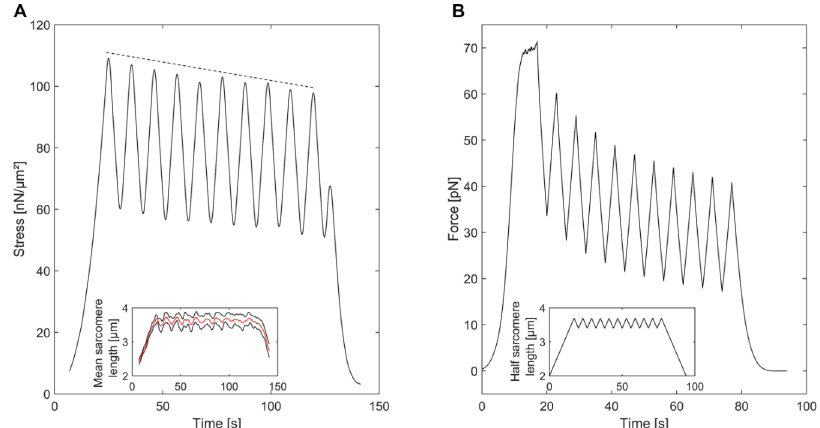
Fig 7. Hysteresis cycles of a single myofibril. A A single myofibril consisting of 7 sarcomeres was stretched to an averaged sarcomere length of 3.7 μ m and subsequently cycled by approximately ± 2.5 μ m. The small insert shows the corresponding average sarcomere length (red line) ± standard error (black lines). The peak forces declined from the first to the second last peak. B The average force of Monte Carlo simulations based on 200 titin strands and a simplified half sarcomere length behavior (small insert) show a decline of peak forces based on the folding / unfolding behavior of Ig domains.